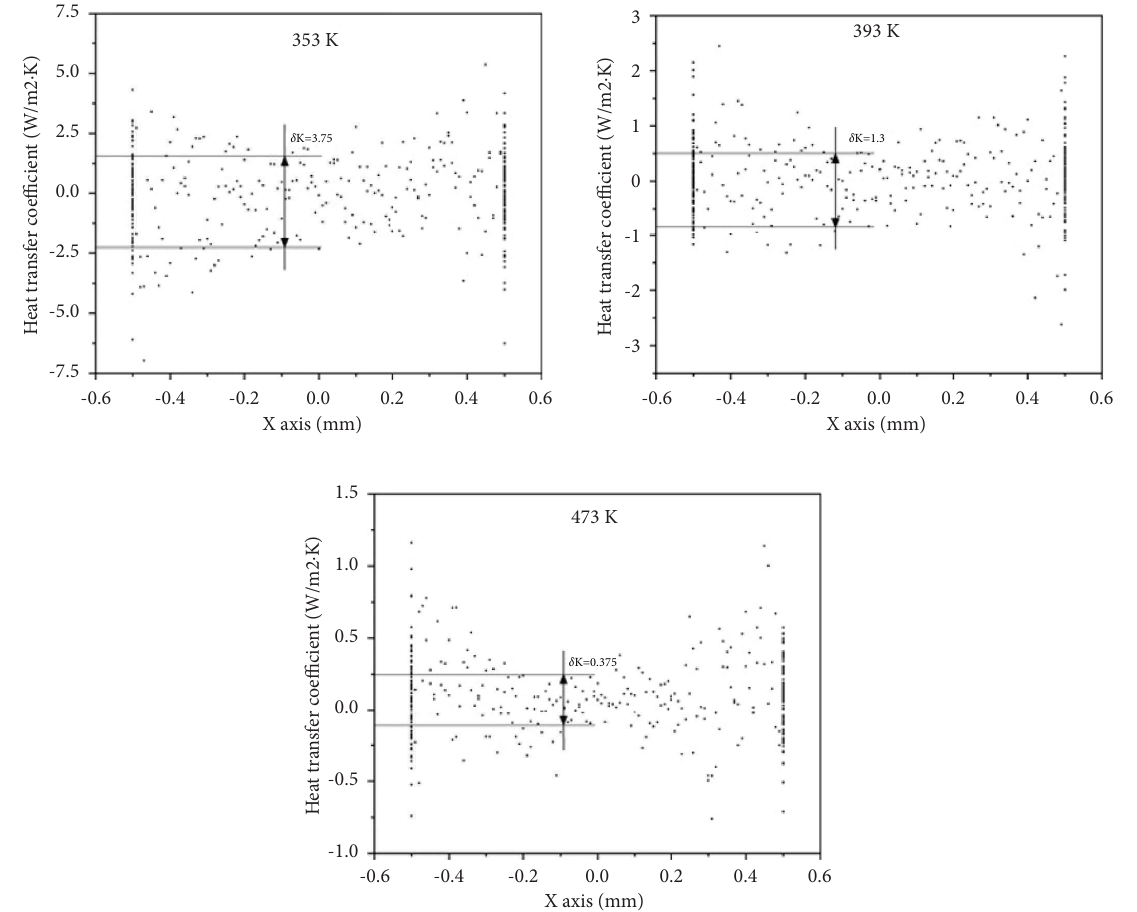
Figure 8: Heat transfer coefcient in parallel to collision direction on the XY plane at the initial temperatures of 353 K, 393K, and